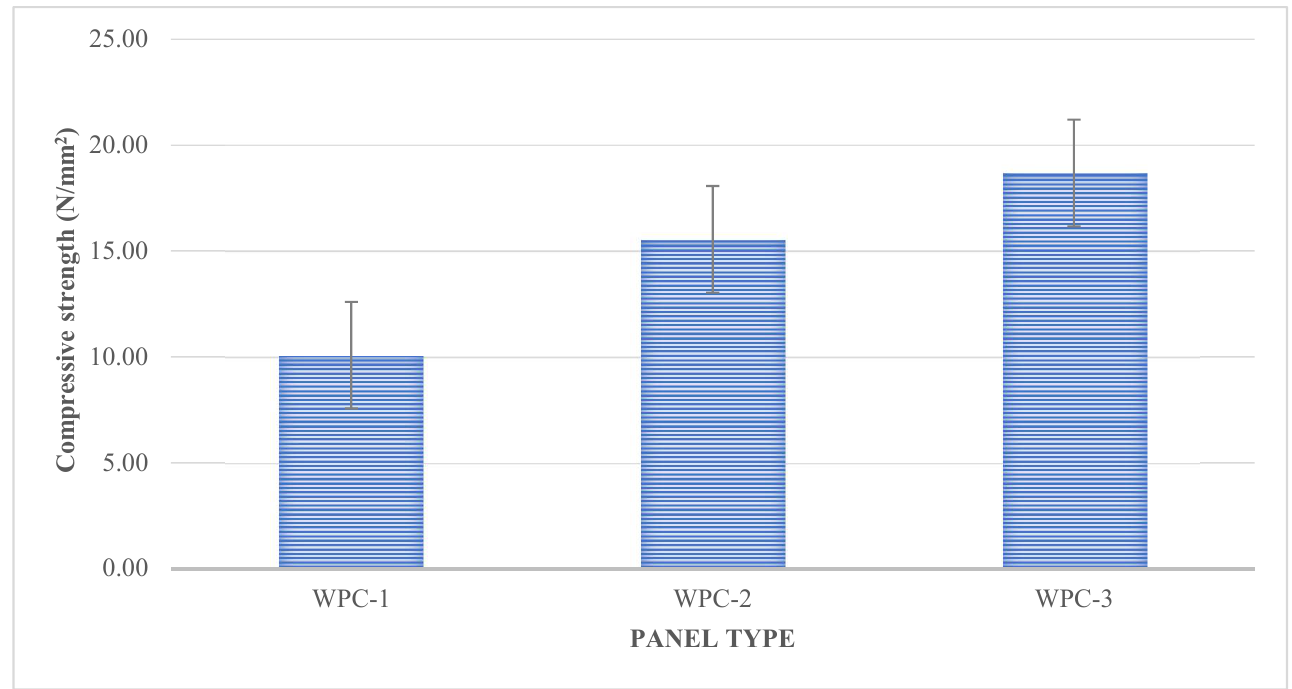
Figure 5. Compressive strength of the samples.